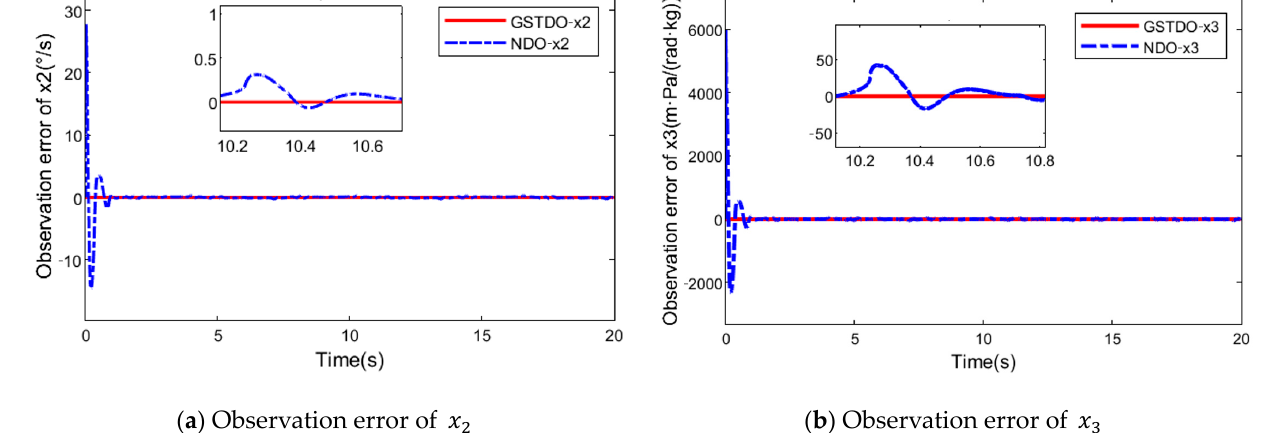
Figure 14. Comparison of the observation error of GSTDO and NDO in Experiment 2.